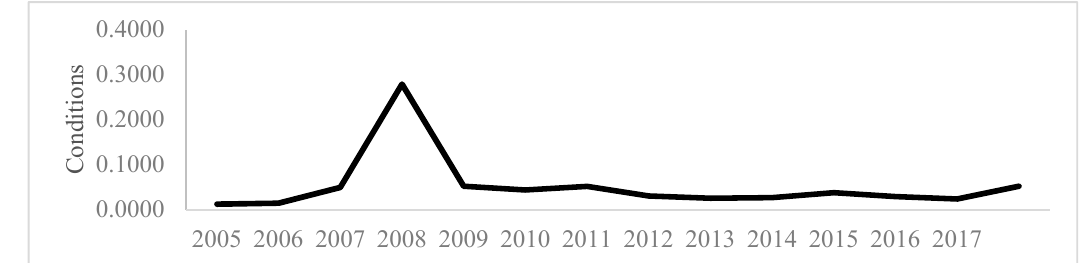
Figure 3. Trend in Conditions .